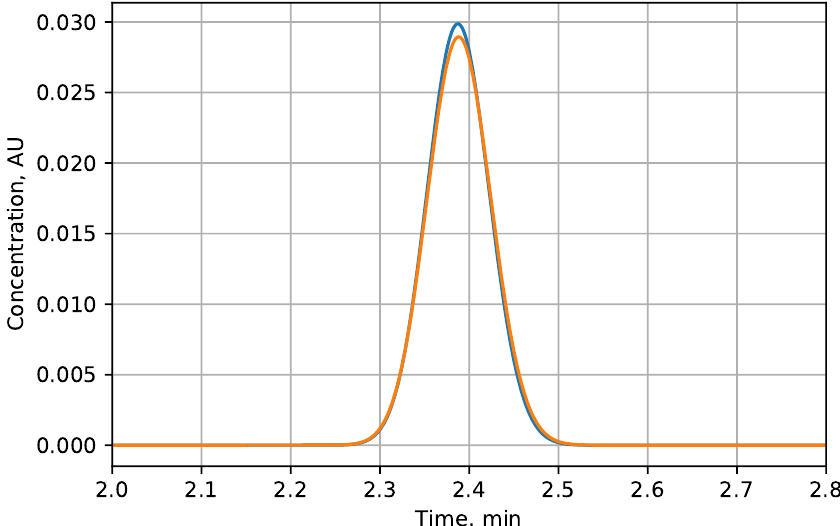
Figure 3. Peaks of the di2 ion calculated for the gradient column (blue) and for the uniform (orange) column (AU—arbitrary